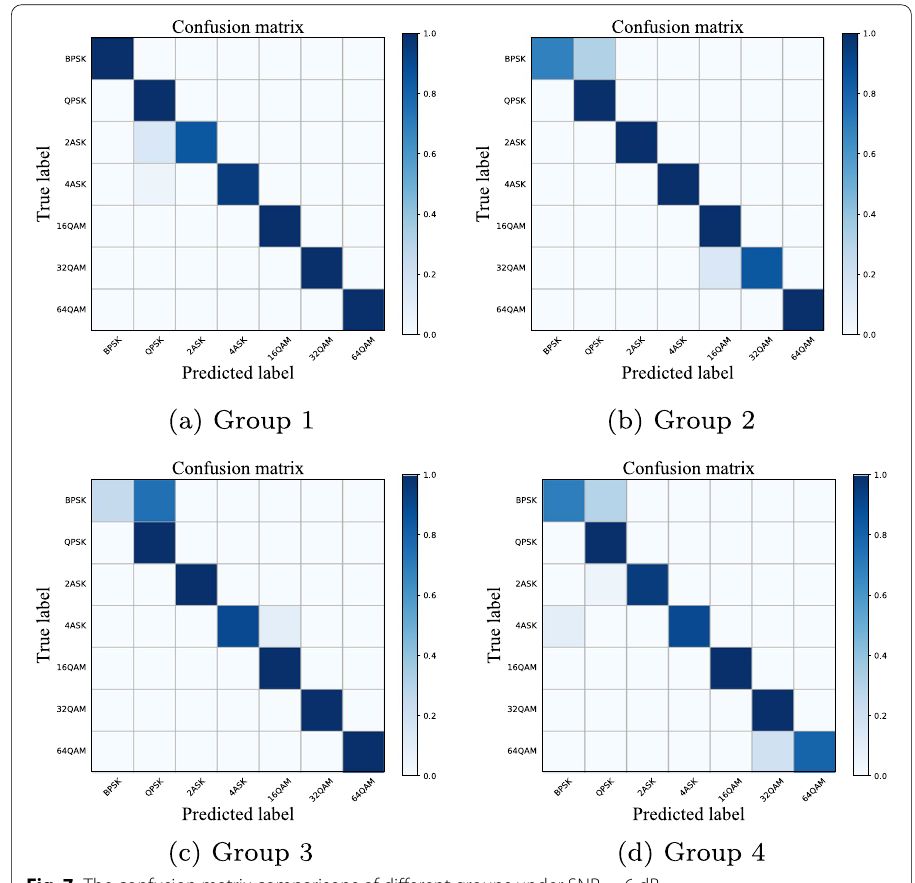
Fig. 7 The confusion matrix comparisons of different groups under SNR